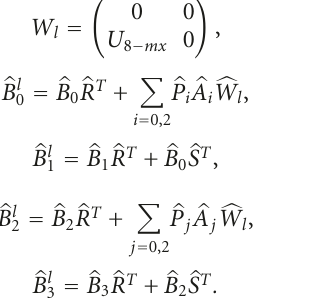
0 predicted + ( − 1,0). n + (0,1). (d) Overlap n + (0, − n